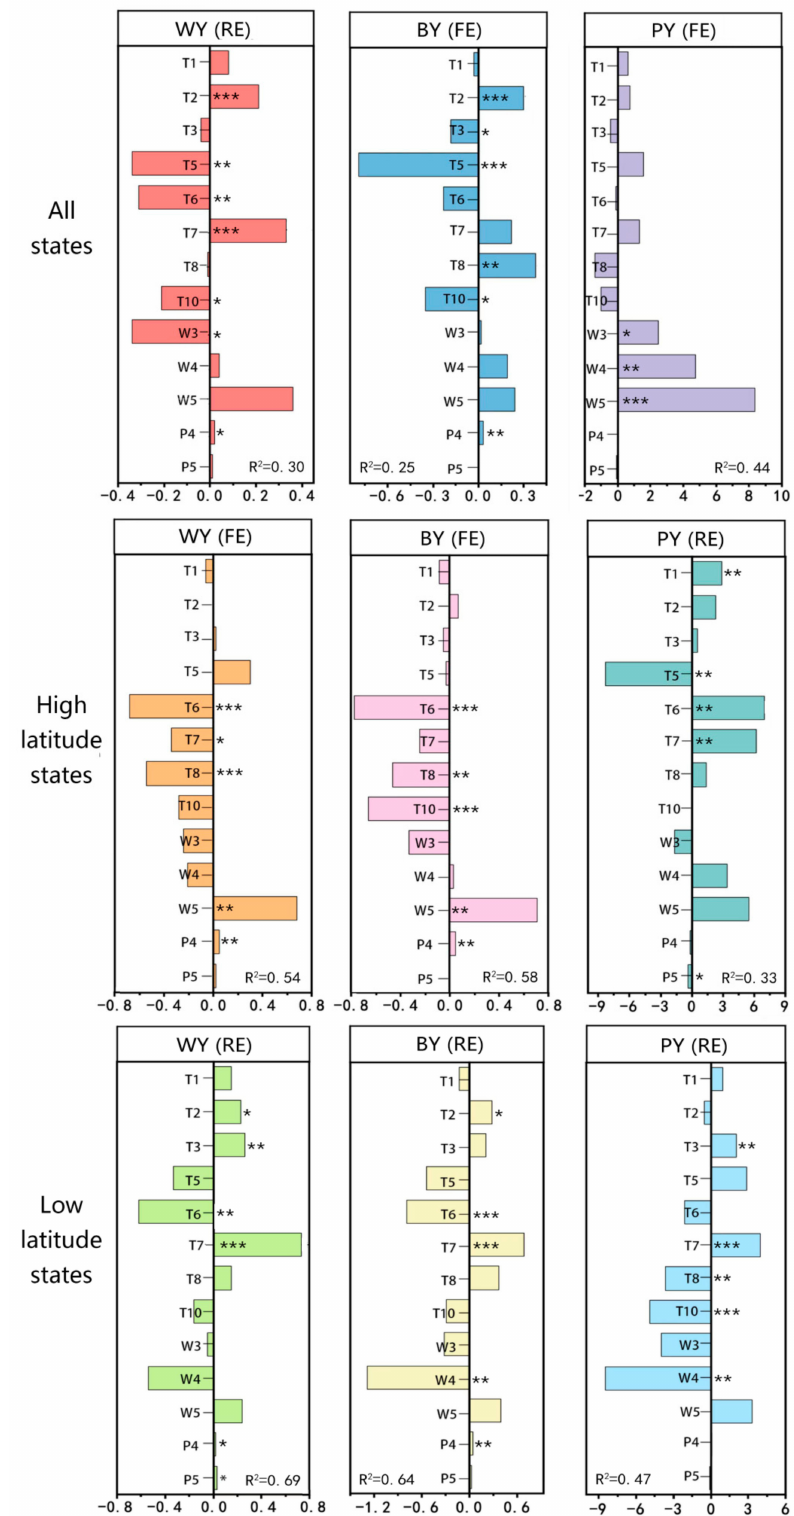
Figure 6. The effects of climatic factors on yield of staple crops. Note: p < 0.01 ***; 0.01 ≤ p <0.05 **; 0.05 ≤ p < 0.1